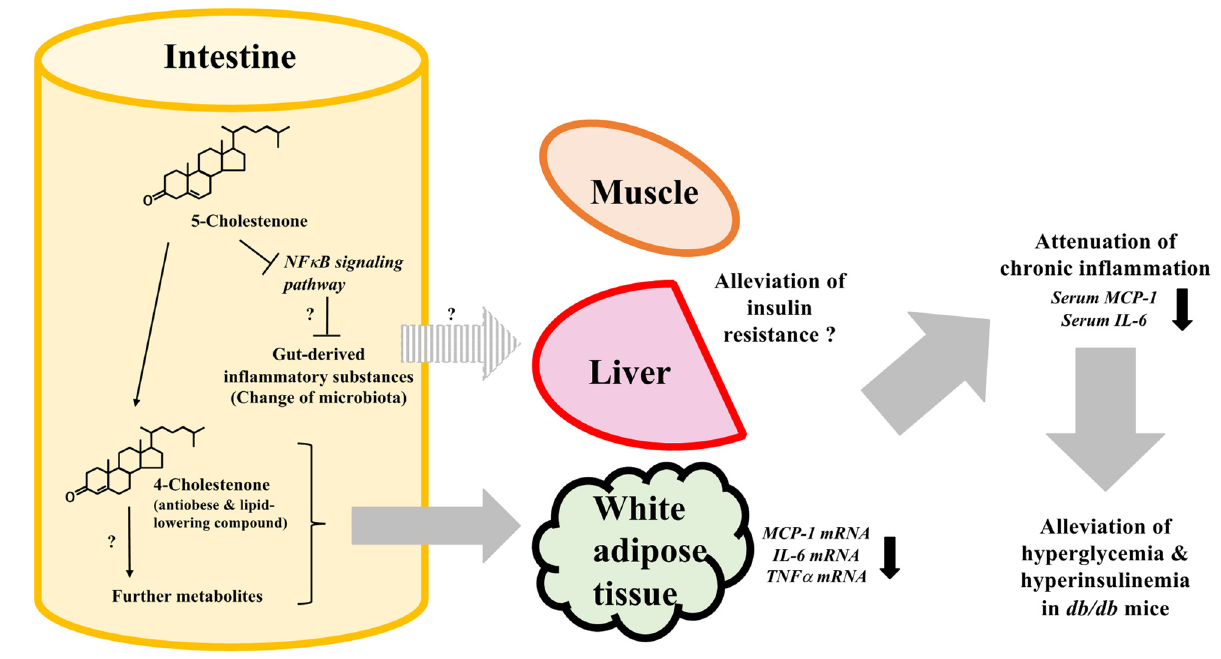
Figure 6. The proposed molecular mechanism by which 5-cholestenone affects metabolic disorders in db/db mice.